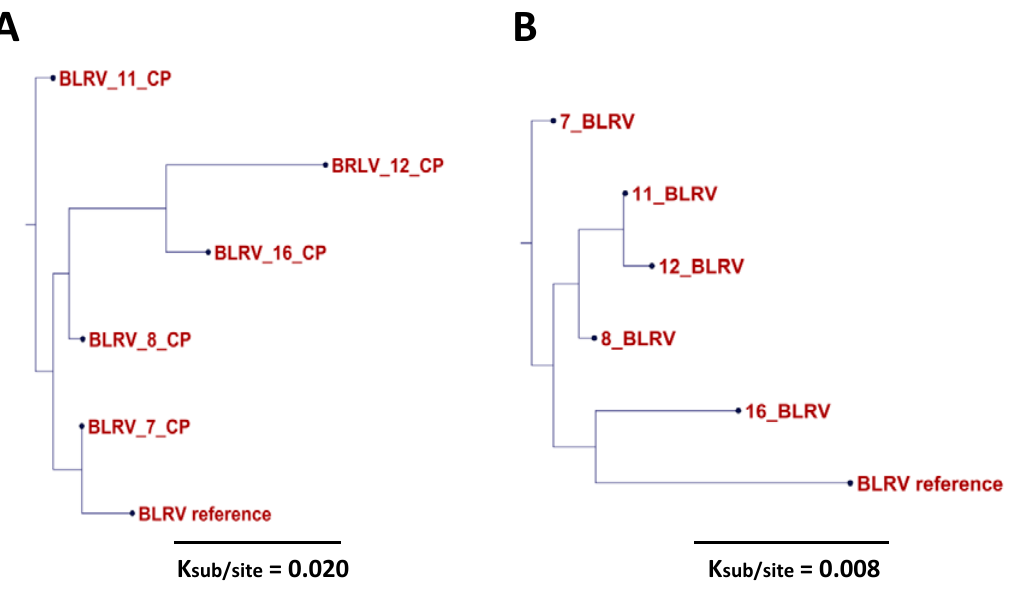
K sub/site = 0.020 K sub/site = 0.008